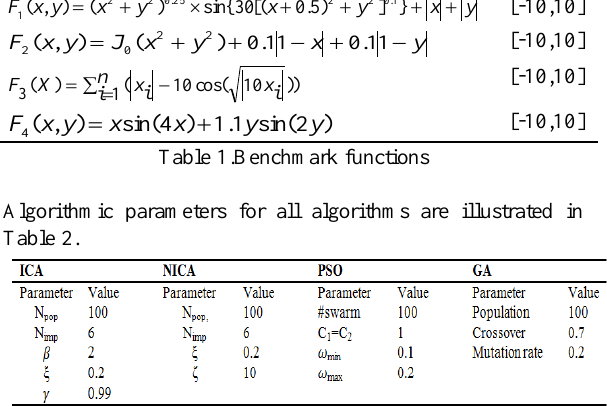
Table 2. parameter values of implemented algorithms